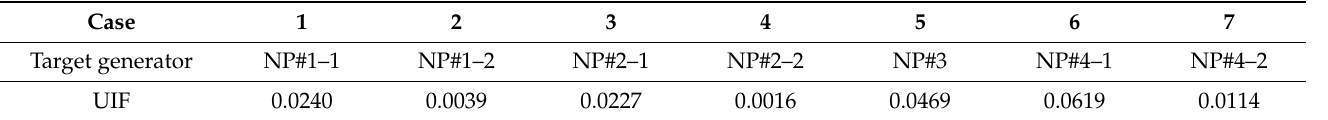
Table 3. UIF Screening